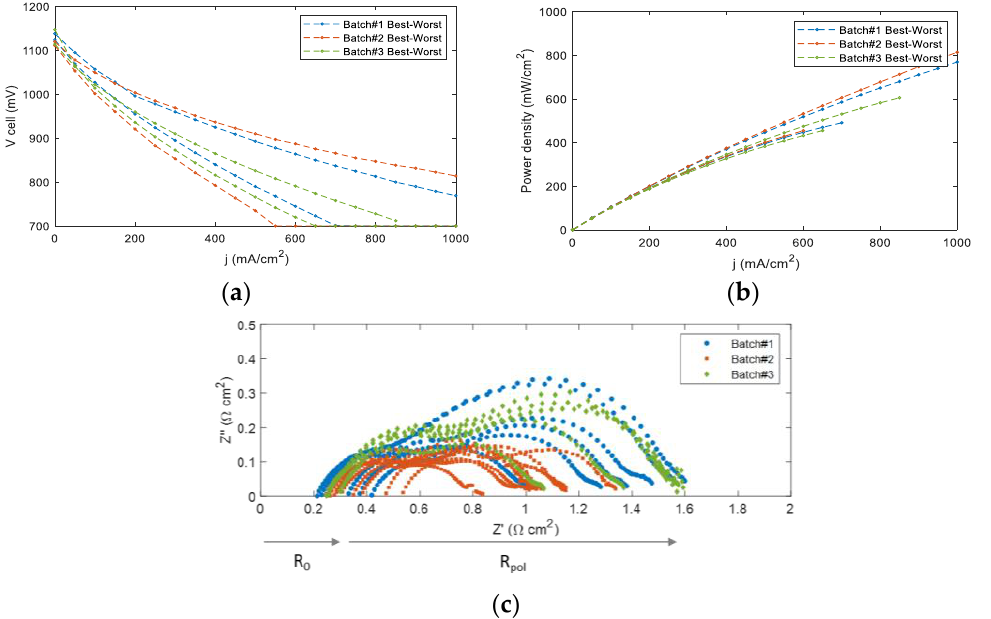
Figure 5. Experimental data (StdCond)—( a ) IV curves; ( b ) power density curves and ( c ) EIS measure- ments; from